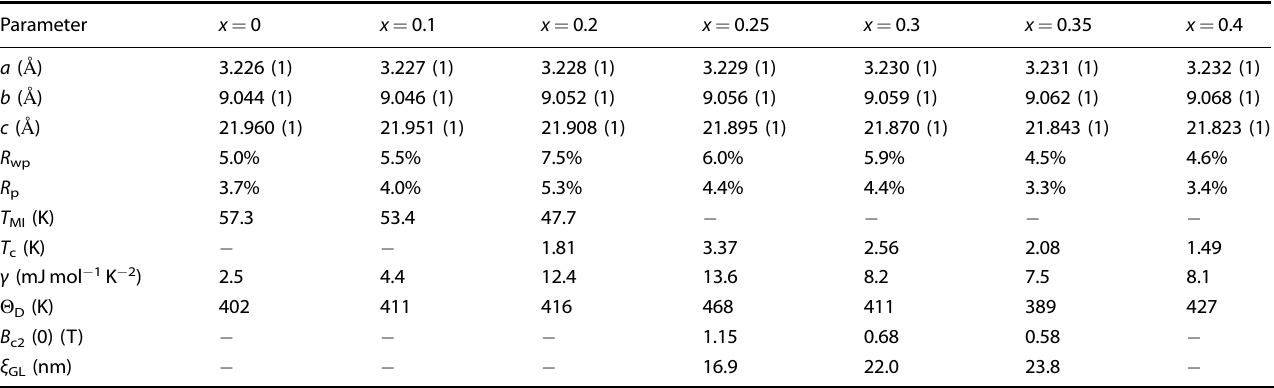
Table 2. Structural re fi nement results and physical parameters of Re 3 Ge 7 − x Ga x